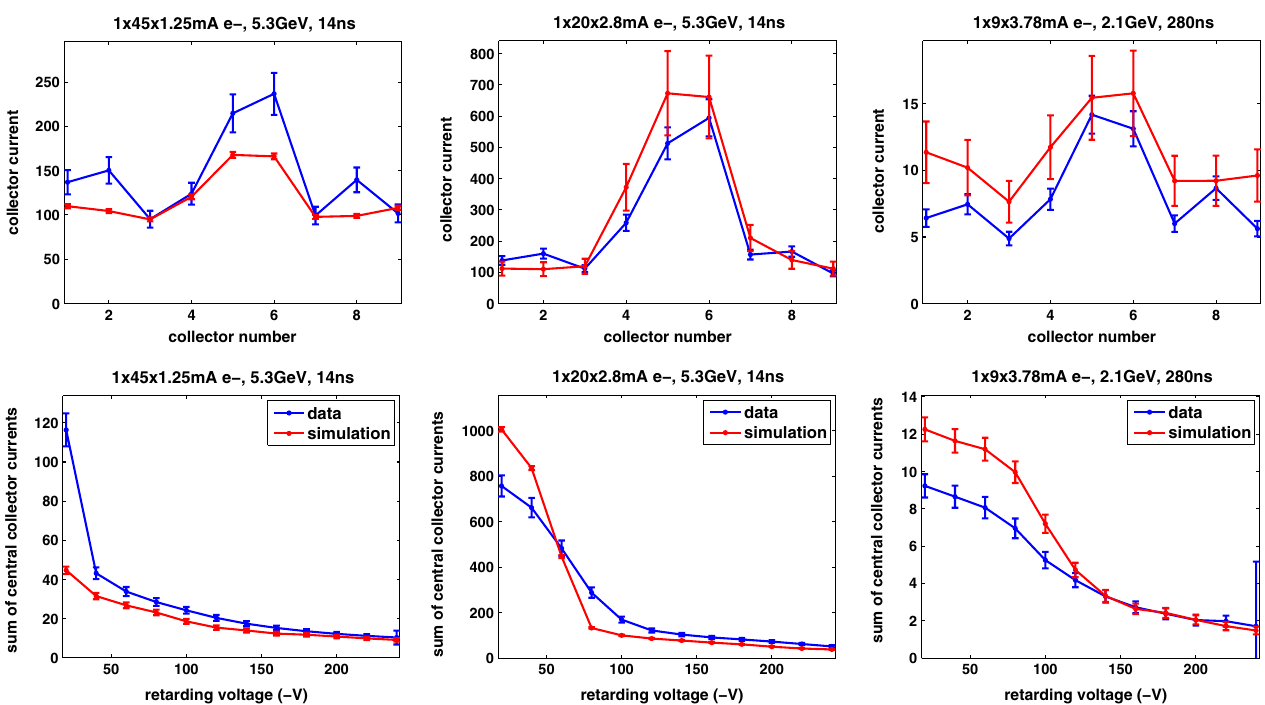
FIG. 9. Comparison of Q15W Al RFA data and simulation, using best fit parameters (Table VII), conditions 13 – 15 (Table VI). The RFA is “ thin ” style (Table II). The top plots show the total signal across the 9 RFA collectors (with þ 50 V on the grid); the bottom plots show the signal in the central three collectors vs retarding voltage.